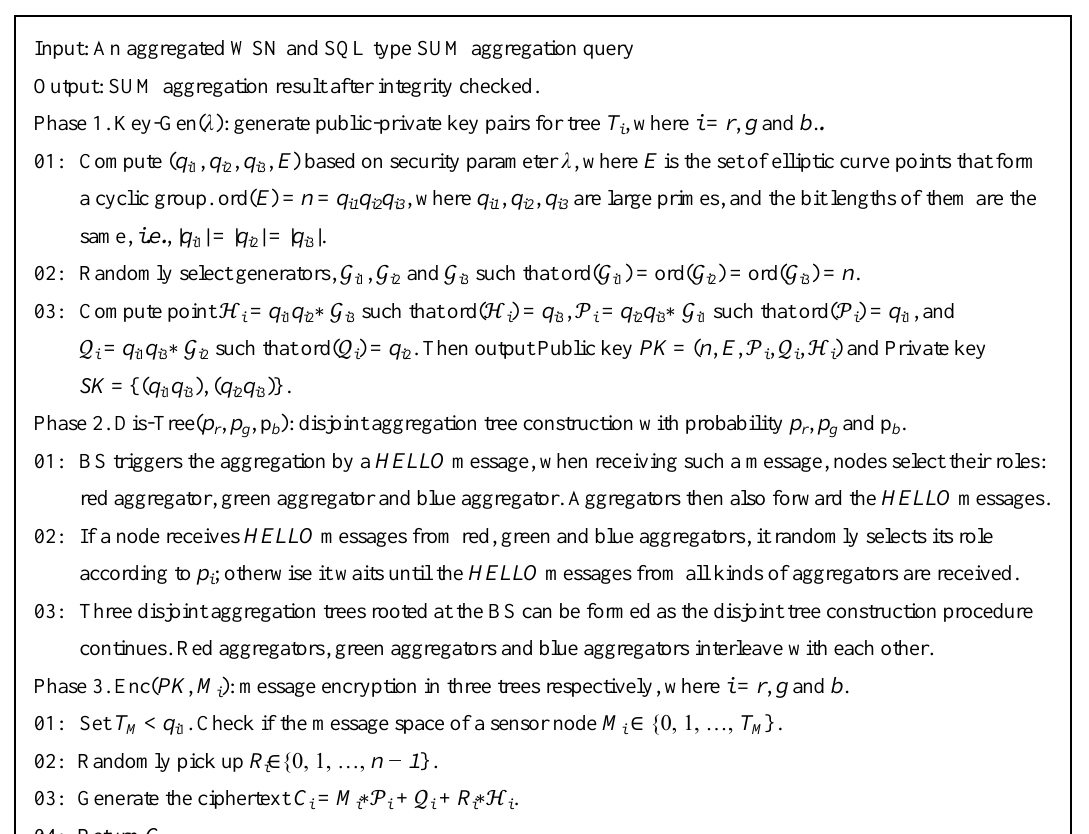
Algorithm 2. SEDA-ECC